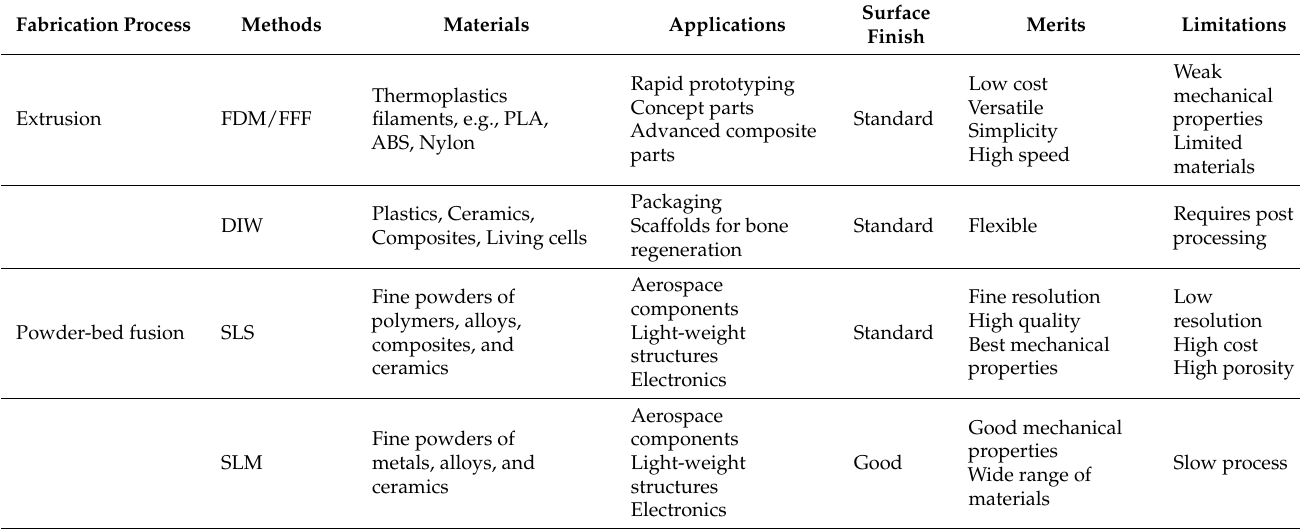
Table 1. A comparison of additive manufacturing printing processes, materials used, applications, and pros and cons. Table adapted from [63–64].